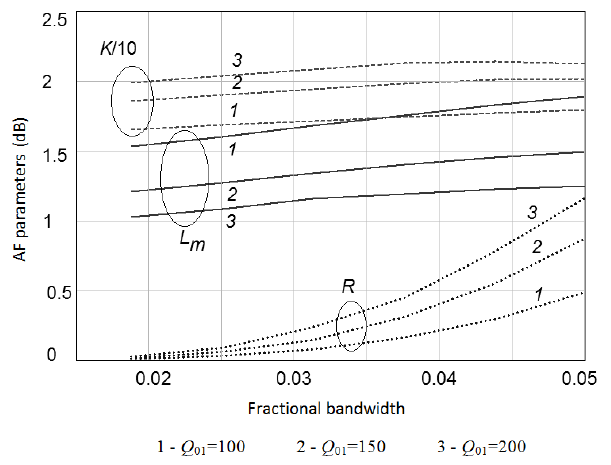
Fig. 3. AF parameters vs. fractional bandwidth at f 0 = 1.6 GHz, Q 02 = 1000, Q r = 60, Q 01 = 100 (curve 1), 150 (curve 2), and 200 (curve 3).